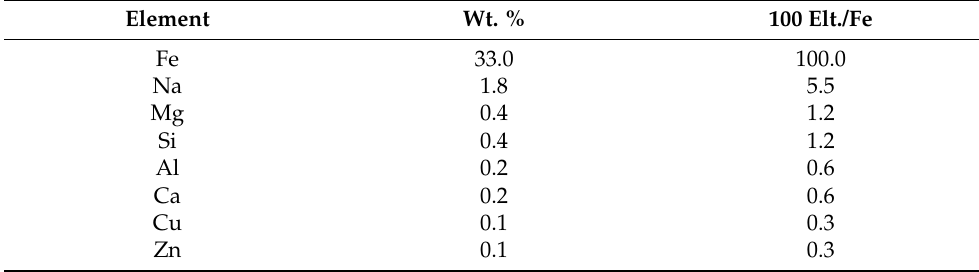
Figure 6. X-ray diffraction pattern of sulfide QS-1. Table 6. Element contents of sulfide